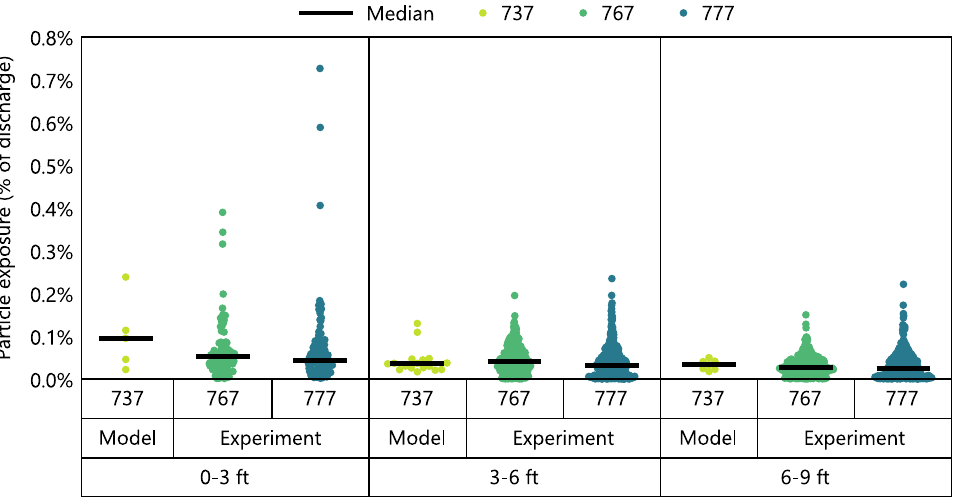
Figure 7. Particle exposure in the computational model using the 737 airframe and in experimental testing using 767 and 777 airframes. Jittered datapoints represent exposures of individual susceptible passengers within bins by distance to the index subject.